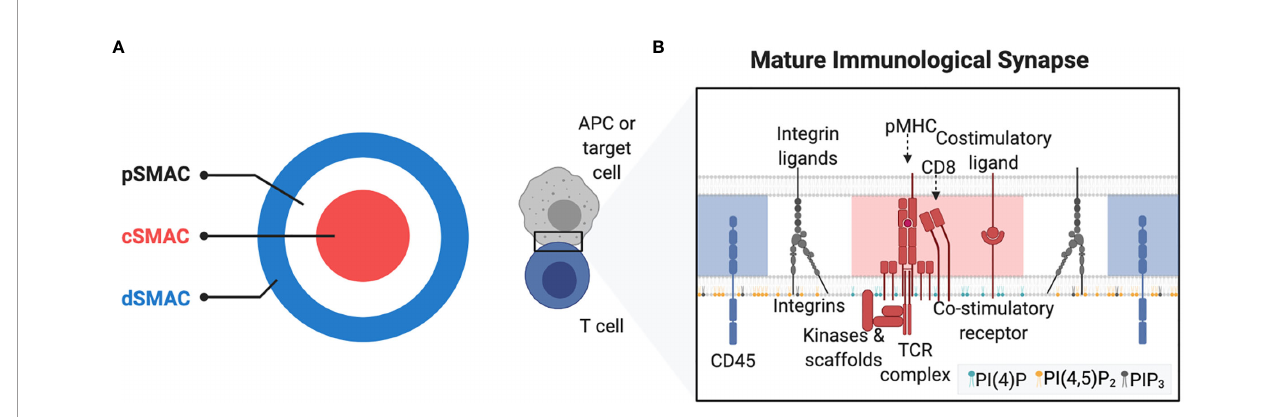
FIGURE 3 | Phospholipids in the immunological synapse. (A) shows the bulls eye of the synapse in the Z-plane. (B) Schematic of the immunological synapse showing approximate location of critical receptors in the distal SMAC (dSMAC), peripheral SMAC (pSMAC), and central SMAC (cSMAC) as well as approximate composition of the phosphoinositols PI (4)P, PI (4,5)P 2 and PI (3,4,5)P 3 in the inner lea fl et of the T cell. Figure made in